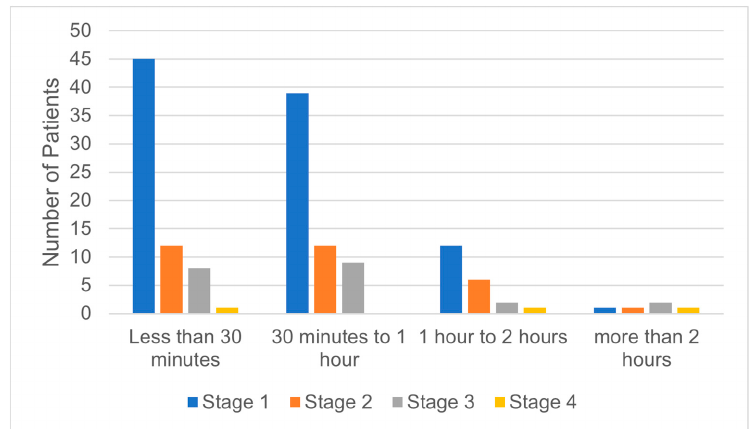
Figure 3. Correlation between tumor stage and time required to perform surgery.